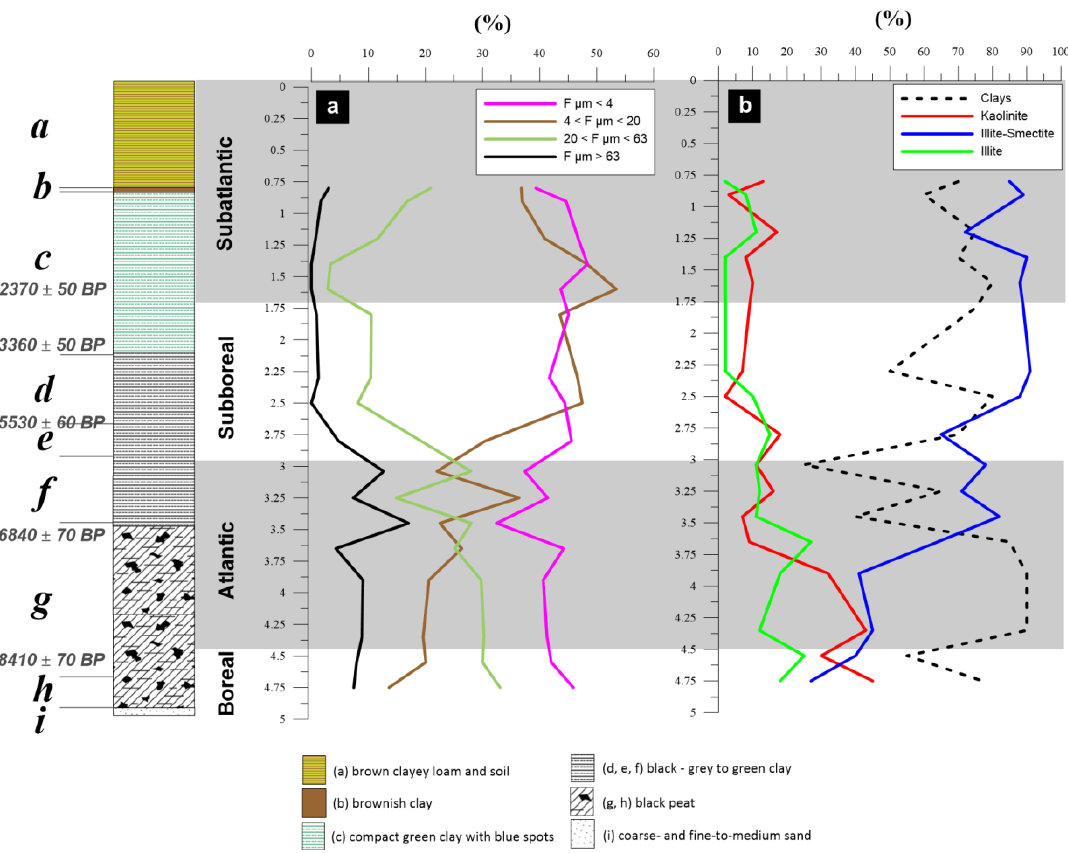
Figure 2. Variations of particle size (%, a ) and clay content (%, b ) in the M25B core. Radiocarbon dates are from [12], see Table 1 for more details and text for the location of the 14 C dates.